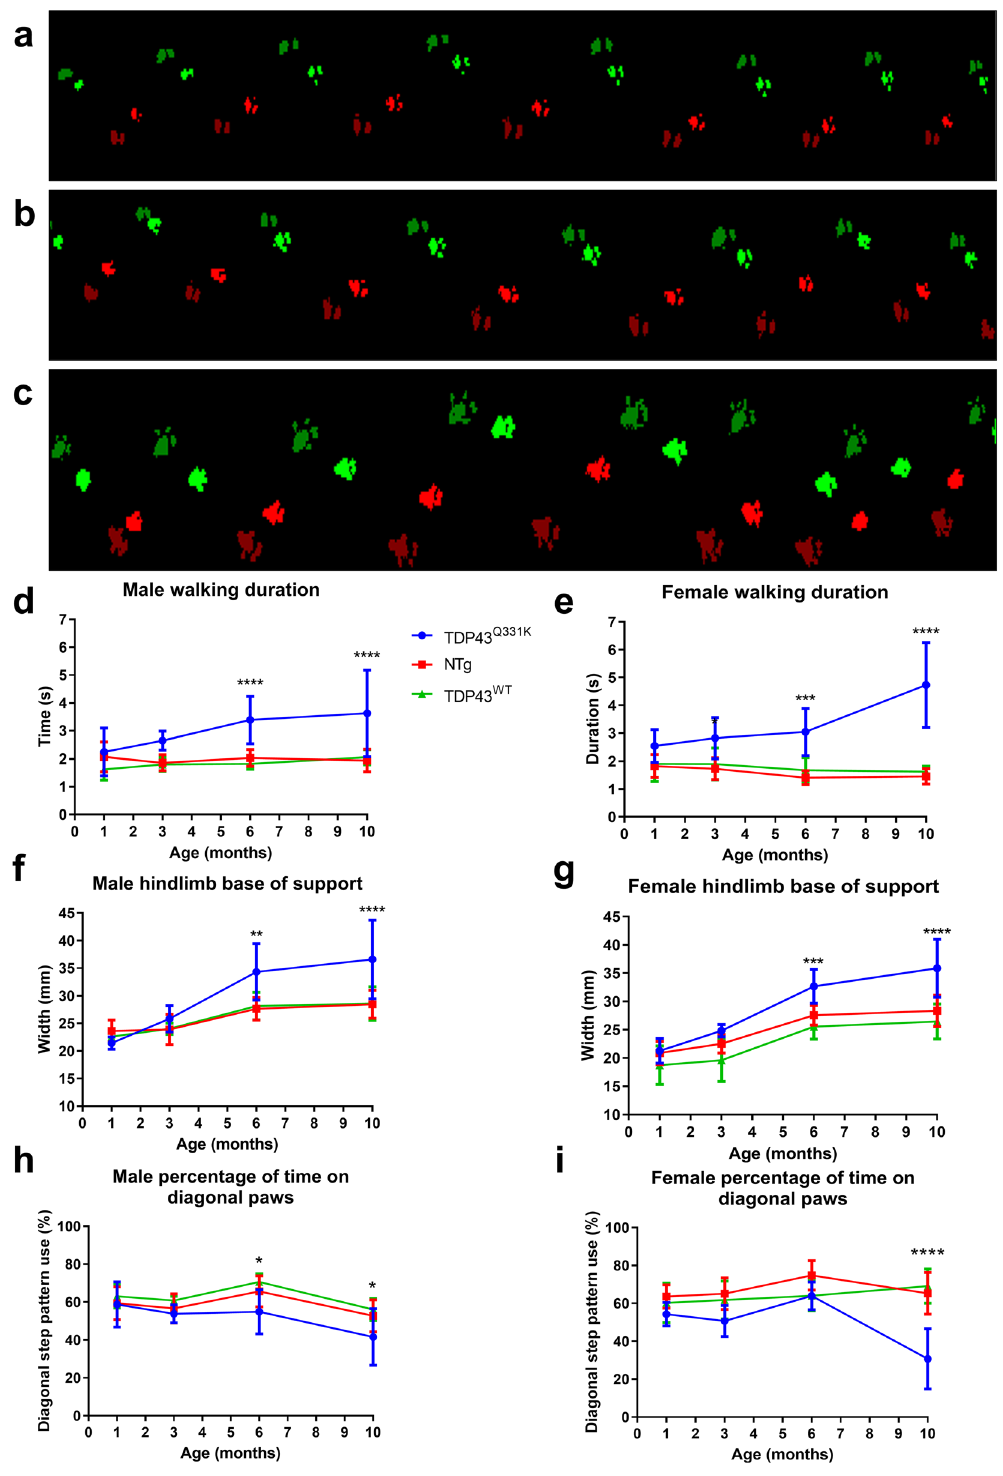
Figure 2. CatWalk gait analysis showing paw print patterns; walking duration, hindlimb base of support and diagonal pattern walking in TDP-43 Q331K mice compared to TDP-43 WT and non-transgenic mice. Footprint traces of non-transgenic